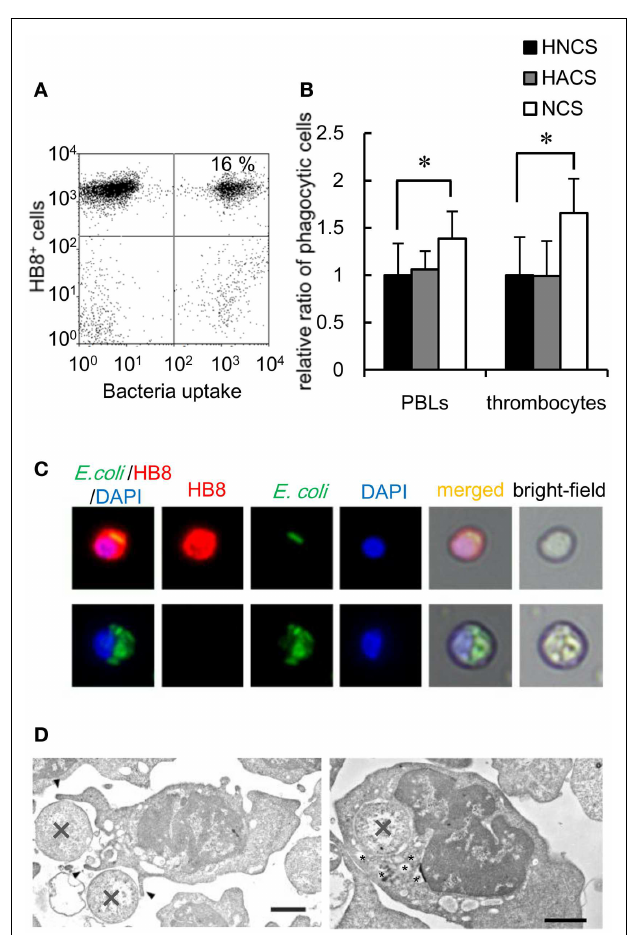
FIGURE 4 | Bacterial phagocytosis by thrombocytes and other leukocytes is shown . (A) Flow cytometry of common carp PBLs incubated with FITC-conjugated E. coli for 3h at 25°C . The number indicates the percentage of phagocytic cells in HB8 + thrombocytes. (B) Quantification of the effects of oposonization by incubation with heat-inactivated normal carp serum (HNCS), heat-inactivated anti- E. coli carp serum (HACS), and normal carp serum (NCS). Data are expressed as the average of five independent experiments, shown as mean ± SD.The asterisks (*) indicate significant differences from the control, as analyzed by Student’s t -test ( P < 0.05). (C) Phagocytic common carp thrombocytes (upper) and mAb - phagocyte (lower)-ingested bacteria; red, HB8 mAb; green, bacteria; blue, nuclei stained with DAPI. Original magnification, × 400. (D) Representative transmission electron micrographs of phagocytic thrombocytes in the process of ingesting bacteria (X) via the extension of pseudopods (arrowhead; left) and with ingested bacteria (right). Small vesicles surrounding the internalized bacteria are indicated by asterisks (*). Bar, 1 µ m. Original magnification, ×